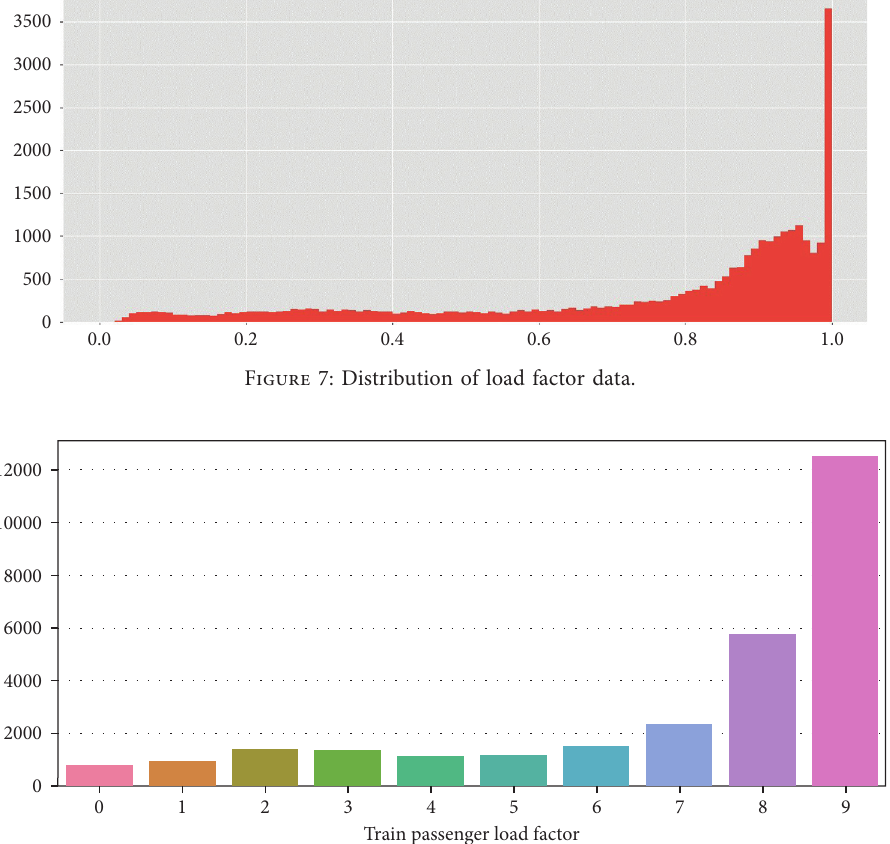
Figure 8: 10 classifications of load factor